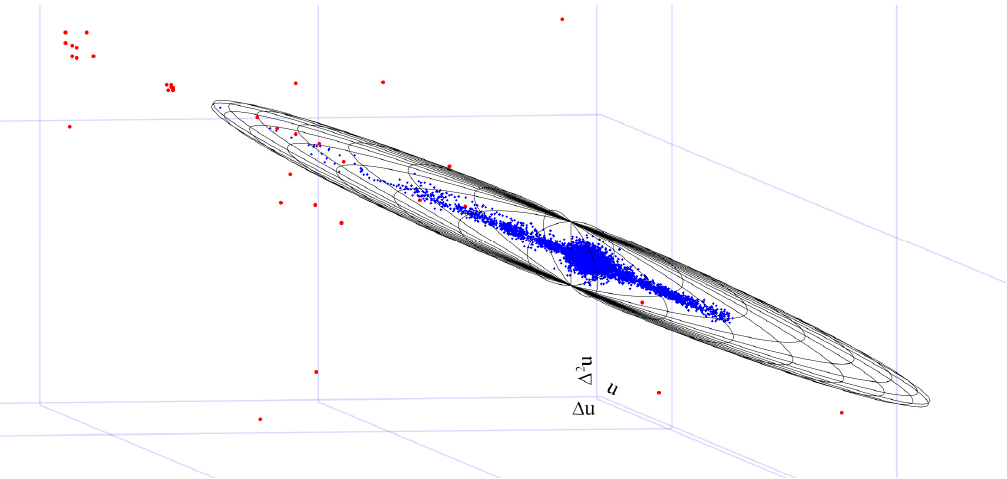
Figure 6. The space-phase method can detect data outliers in an efficient manner. Geomagnetic readings falling outside of the 3D ellipsoid (in red) are tagged as data spikes.